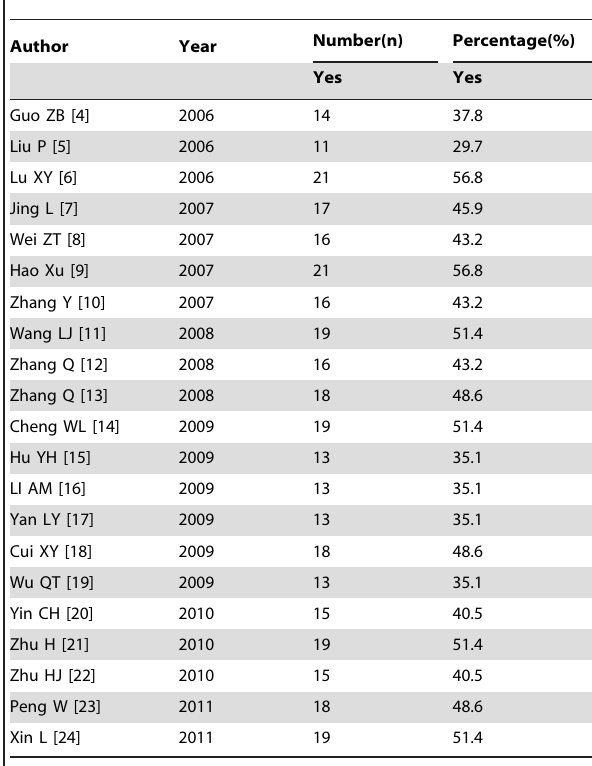
Table 1. The reporting number and percentage for each article of the CONSORT checklist in